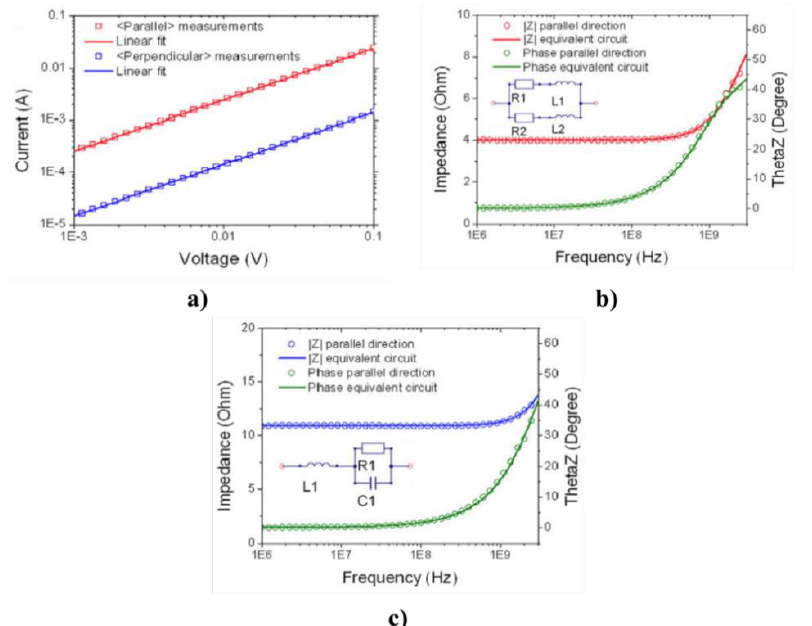
Figure 34. Electrical characterizations of MWCNT/EP composites. ( a ) Current – voltage data for composites, ( b ) impedance and phase vs. frequency data (circles) with the corresponding equivalent circuit model (lines) for the parallel direction, and ( c ) impedance and phase vs. frequency data (circles) with the corresponding equivalent circuit model (lines) for the perpendicular direction. Reprinted from [107], Copyright 2010, with permission from Elsevier.